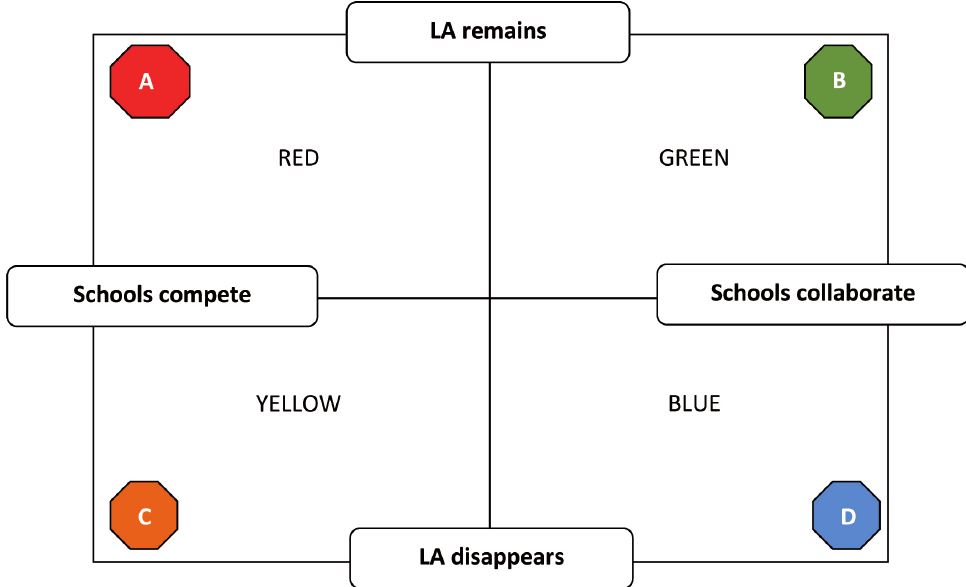
Figure 1: Framework for assessing school and LA responses to the ‘self-improving system’